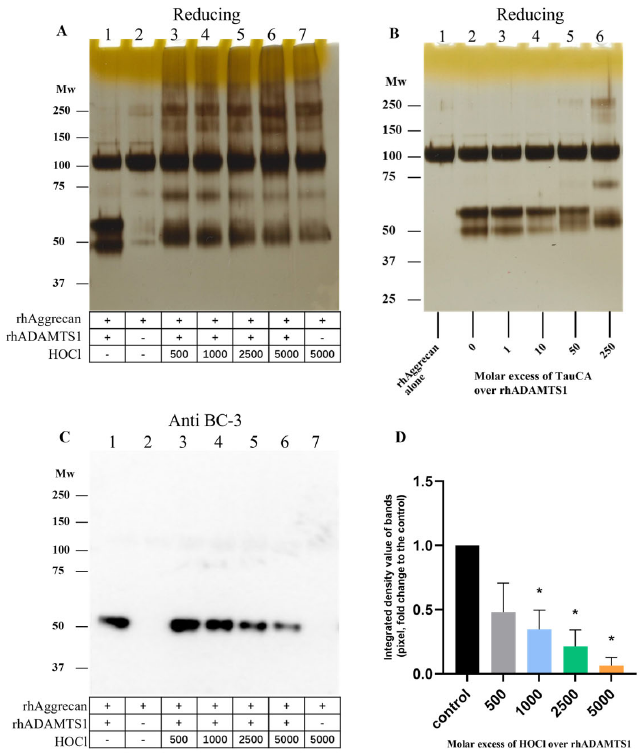
Figure 12. Effects of HOCl and TauCA on rhADAMTS1 ‐ mediated cleavage of rhAggrecan. ( A , C ) rhAggrecan was incubated with rhADAMTS1 in the absence and presence of HOCl at molar ratios of 6.5:1:500–5000 for 24 h at 37 °C, with subsequent analysis by SDS ‐ PAGE (panel A ) and Western blotting by using the BC ‐ 3 mAb (1:1667 dilution) against the neoepitope fragment generated by ADAMTS1 ‐ mediated cleavage of aggrecan (panel C ). Panel D : Densitometric analysis of the pixel density of the bands from panel C determined by using ImageJ relative to the control (no added HOCl; lane 1, panel C ). Panel B: rhADAMTS1 (100 nM) was exposed to 0, 1 ‐ , 10 ‐ , 50 ‐ and 250 ‐ fold molar excesses of TauCA (i.e., 0, 0.1 μ M, 1 μ M, 5 μ M and 25 μ M) for 15 min at 37 °C, before addition to rhAggrecan (643 nM) and further incubation for a total of 24 h at 37 °C. The control (panel B , lane 1) and oxidized samples were then subjected to SDS ‐ PAGE as described in Section 2 with subse ‐ quent silver staining. Images are representative data, and quantitative data are mean values ± SD, each from three independent experiments. Statistical analysis was performed by using one ‐ way ANOVA with Dunnett’s multiple comparisons test with statistical significance compared to the con ‐ trol (0 μ M HOCl) indicated by *, with significance assumed at p < 0.05. 3.9. Effect of TauCA on rhADAMTS1 ‐ Mediated Cleavage of rhAggrecan To determine whether chloramines also modulate rhADAMTS1 activity, experi ‐ ments were carried out with Tau ‐ CA at 0–250 ‐ fold molar excesses for 15 min (Figure 12B), before addition to rhAggrecan and incubation for a total of 24 h at 37 °C. Under these conditions, only modest effects of Tau ‐ CA were detected on rhADAMTS1 cleavage of rhAggrecan. Thus, the two fragments arising from enzymatic cleavage at the aggrecanase site were detected with low concentrations of Tau ‐ CA, with these decreasing in intensity with increasing Tau ‐ CA concentrations. Only at the highest oxidant doses were the frag ‐ ment and dimer bands arising from oxidant damage detected (cf. Figure 6). These data indicate that Tau ‐ CA is less efficient at inhibiting rhADAMTS1 than HOCl.